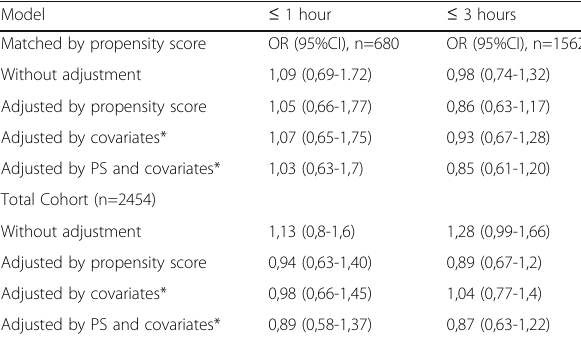
Table 1 (abstract 000546). Effectiveness of antibiotic prescription within one or three hours of admission by emergency services